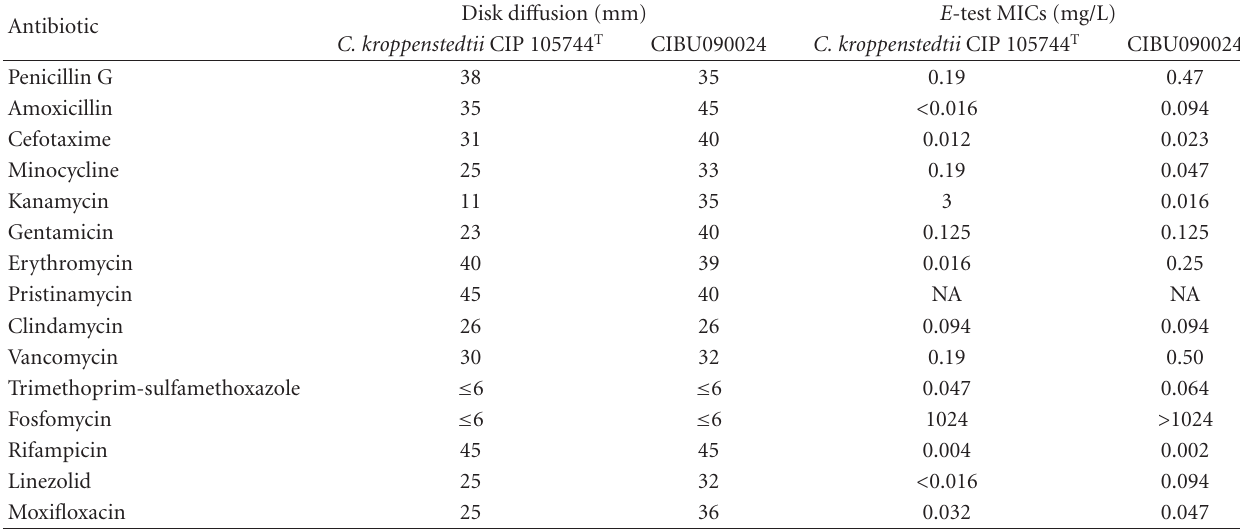
Table 1: Disk di ff usion method compared with E -test MICs for type strain of C. kroppenstedtii CIP 105744 T and our isolate CIBU090024.